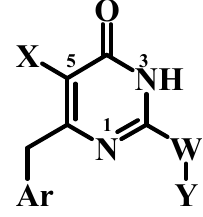
Table 1. Structures of the S- and NH-DABO derivatives and the corresponding HIV-1 RT inhibitory potencies (pIC ) 50